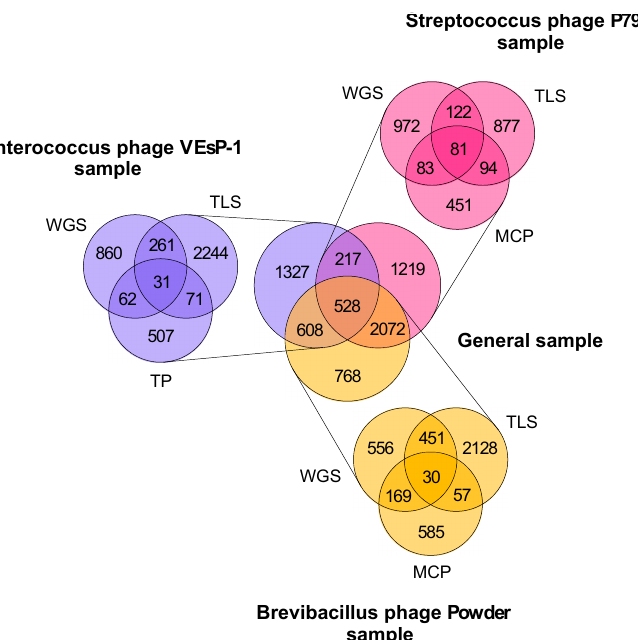
Figure 2. Sequence sample preparation. The numbers of whole genome sequences retrieved in nine BLAST searches with bacteriophage whole genome sequences (WGS), amino acid sequences of